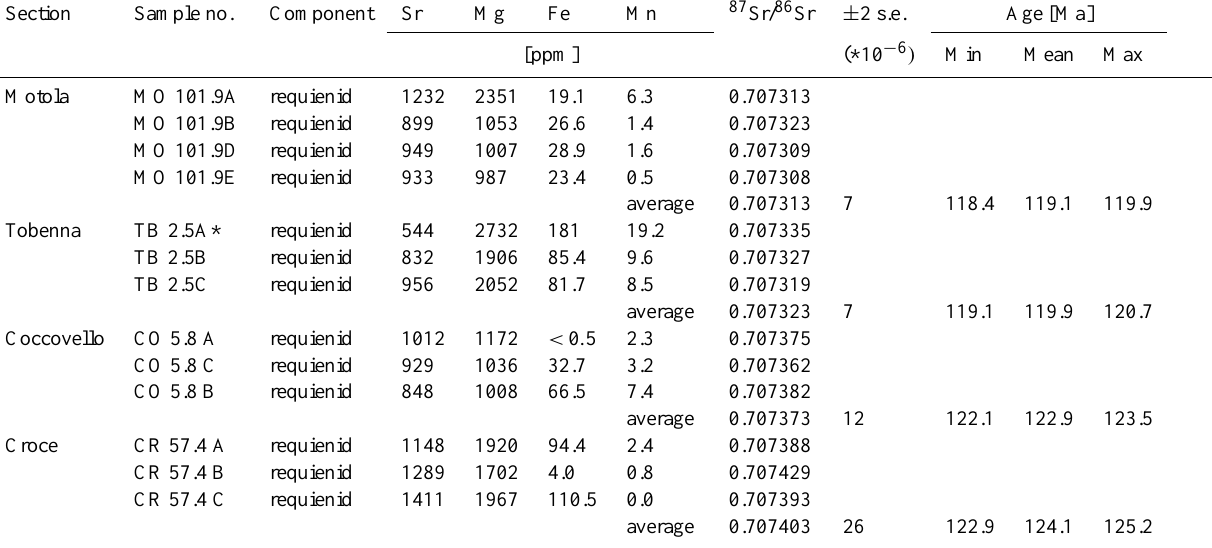
Table 2. Elemental concentration, Sr-isotope ratio and SIS age Section Sample no. Component Sr Mg Fe Mn 87 Sr/ 86 Sr ± 2 s.e. Age [Ma] [ppm] (*10 − 6 ) Min Mean Max Motola MO 101.9A requienid 1232 2351